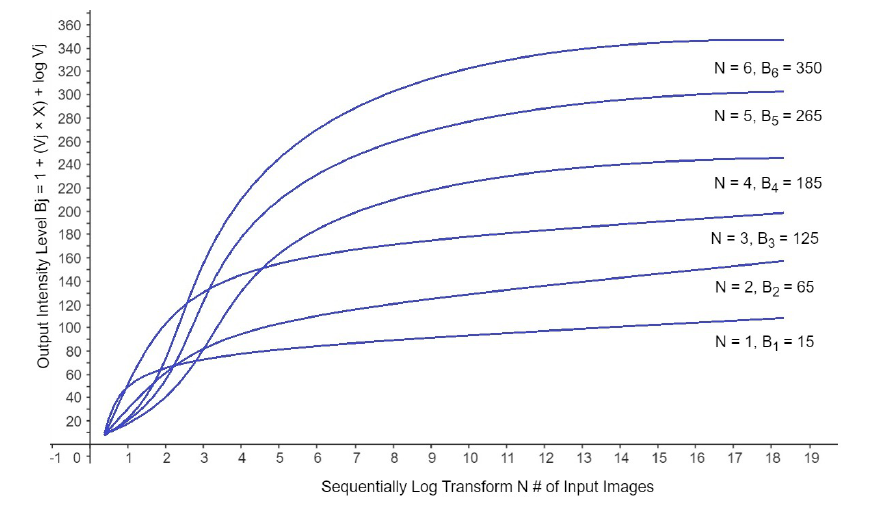
Figure 6. Graphical representation of sequential multiple scale logarithm transformations of the dark input image.